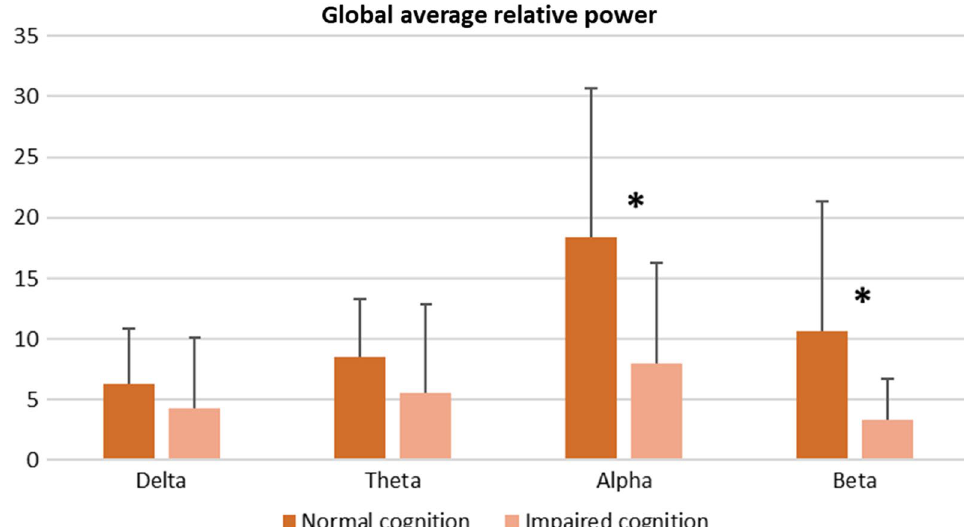
Fig. 5 Global average relative power of the patients with normal and impaired cognition